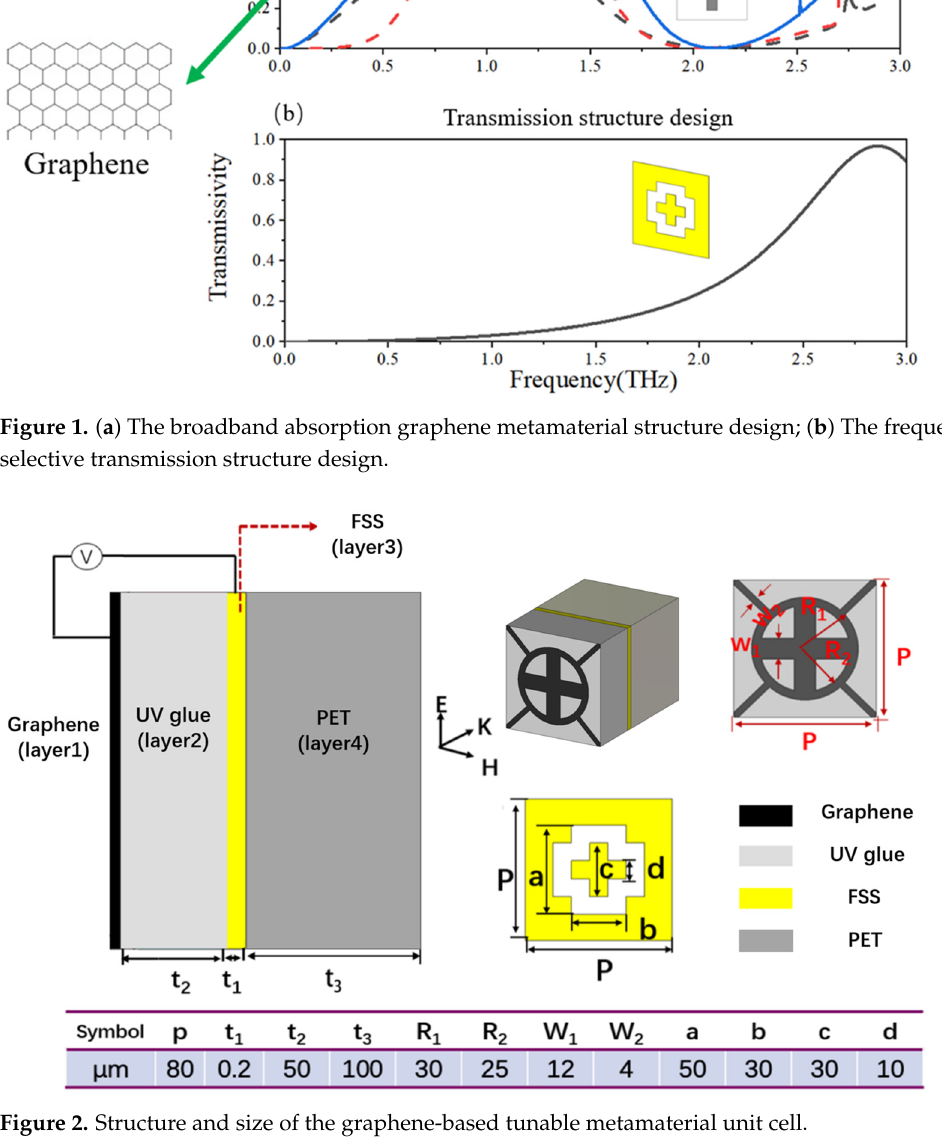
Figure 1. ( a ) The broadband absorption graphene metamaterial structure design; ( b ) The frequency selective transmission structure design.